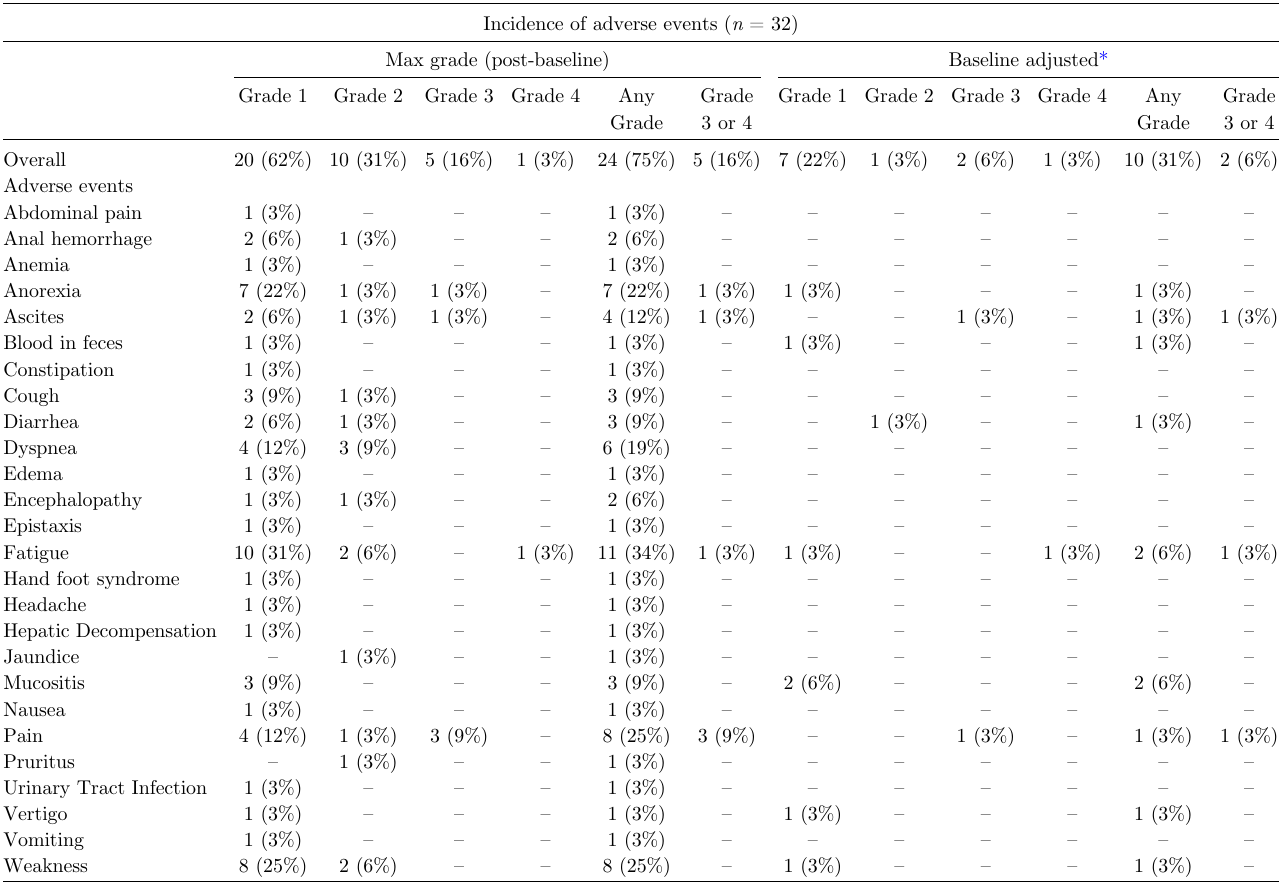
Table 6. Adverse Events Summary – Child-Pugh A Patients Only ( n = 32). Adverse Events reported by NCI CTCAE grade in Child- Pugh A patients receiving treatment with the TheraBionic